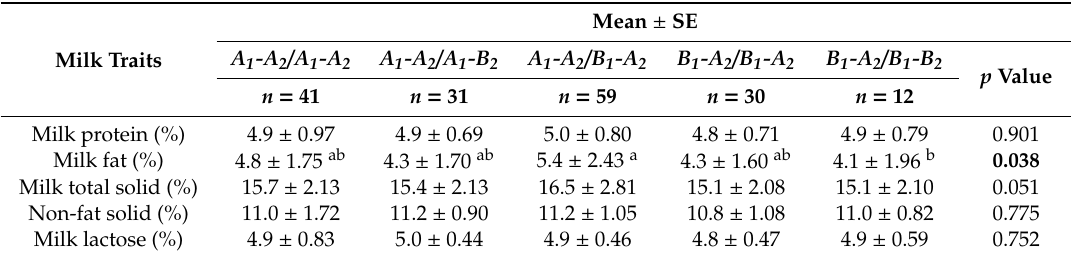
Table 4. Association of FASN diplotypes with milk traits (Mean ± SE) 1 in Gannan yak. Milk Traits